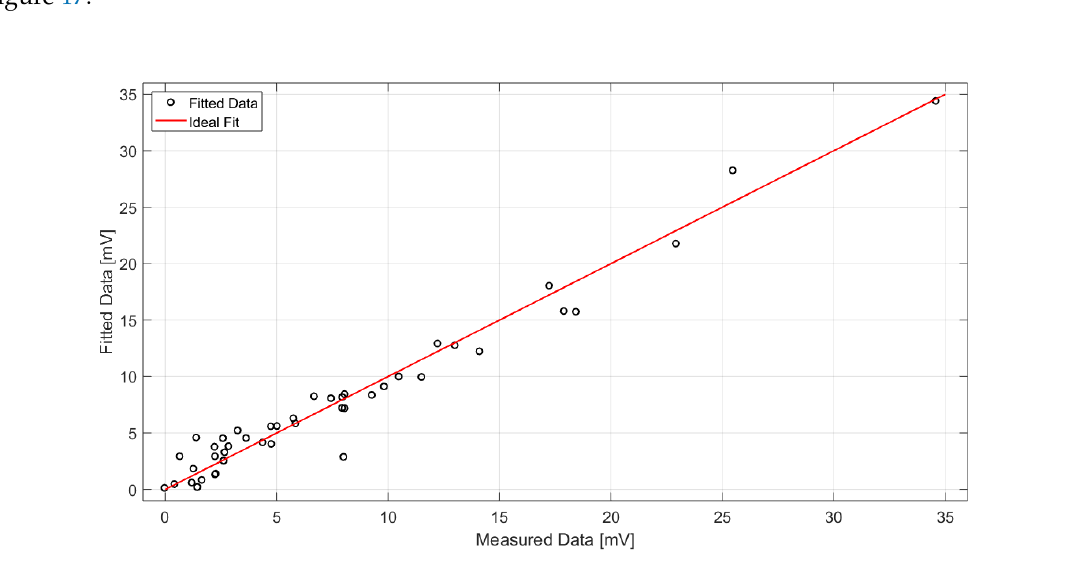
Figure 17. Graphical comparison between the derived fit and the ideal